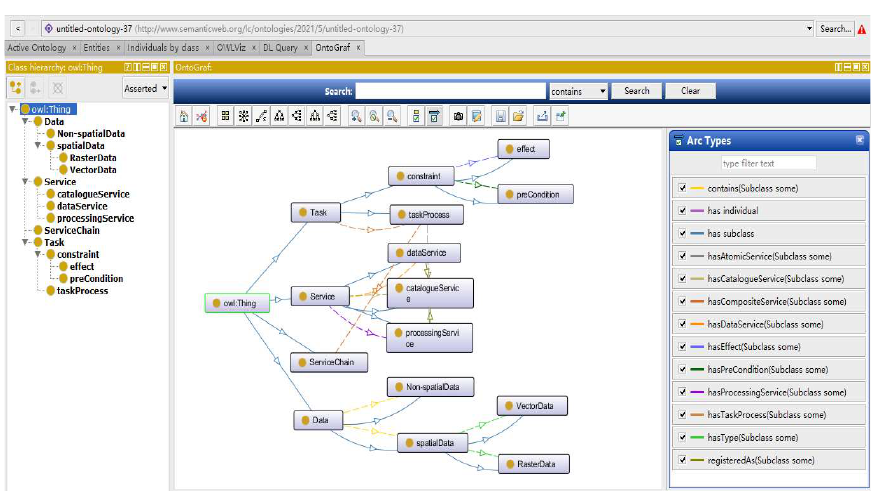
Table 3. A detailed list of defining logical process constraint rules.